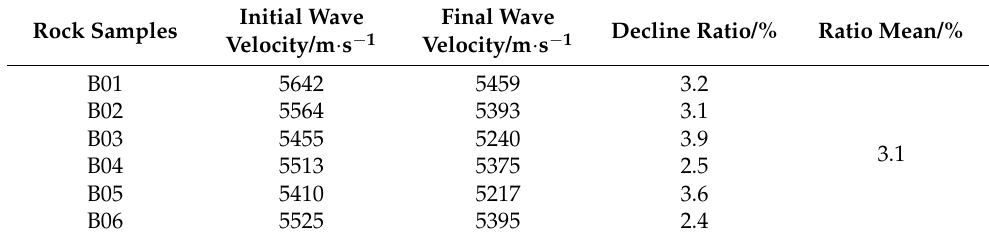
Table 6. Variation of axial wave velocity of rock